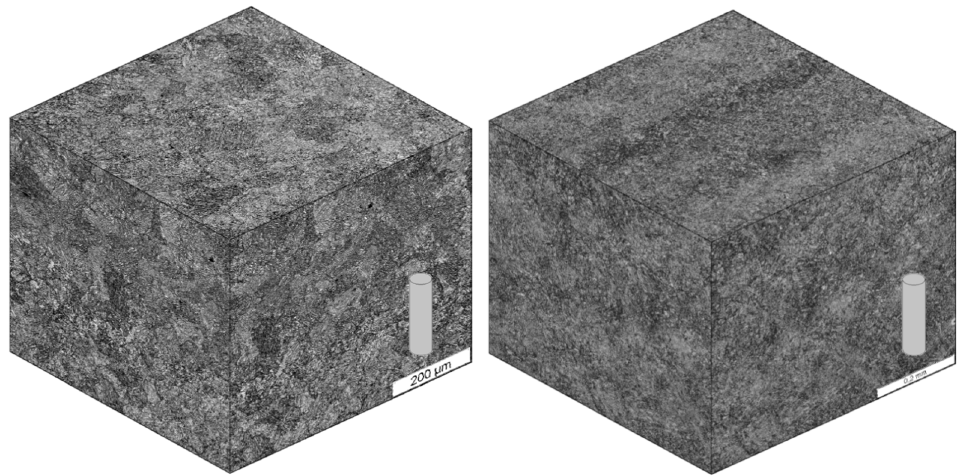
Figure 6. Microstructure of the 2.25Cr-1Mo ( left ) and 3Cr-1Mo-0.25V ( right ).